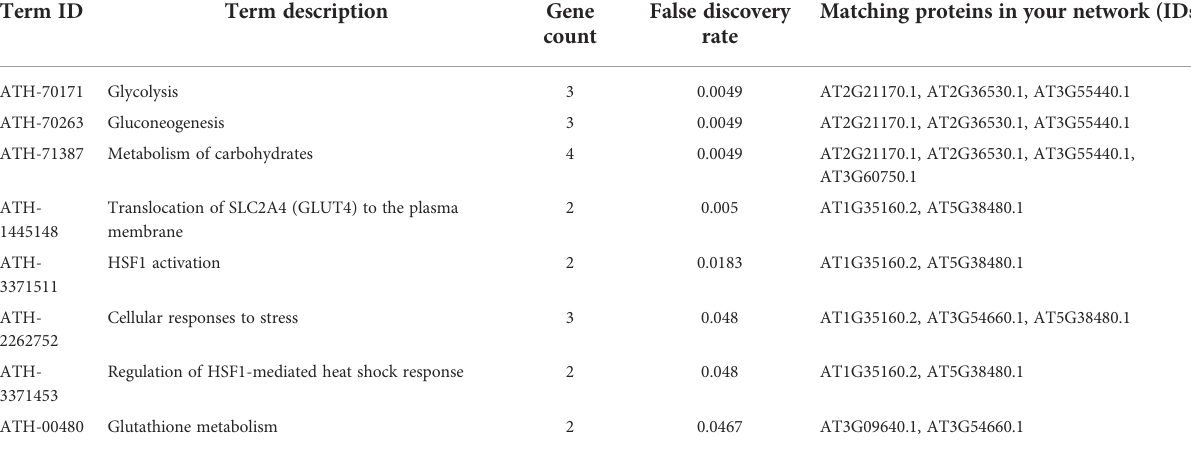
TABLE 1 Enriched pathways based on the Reactome Plant Pathways Database.